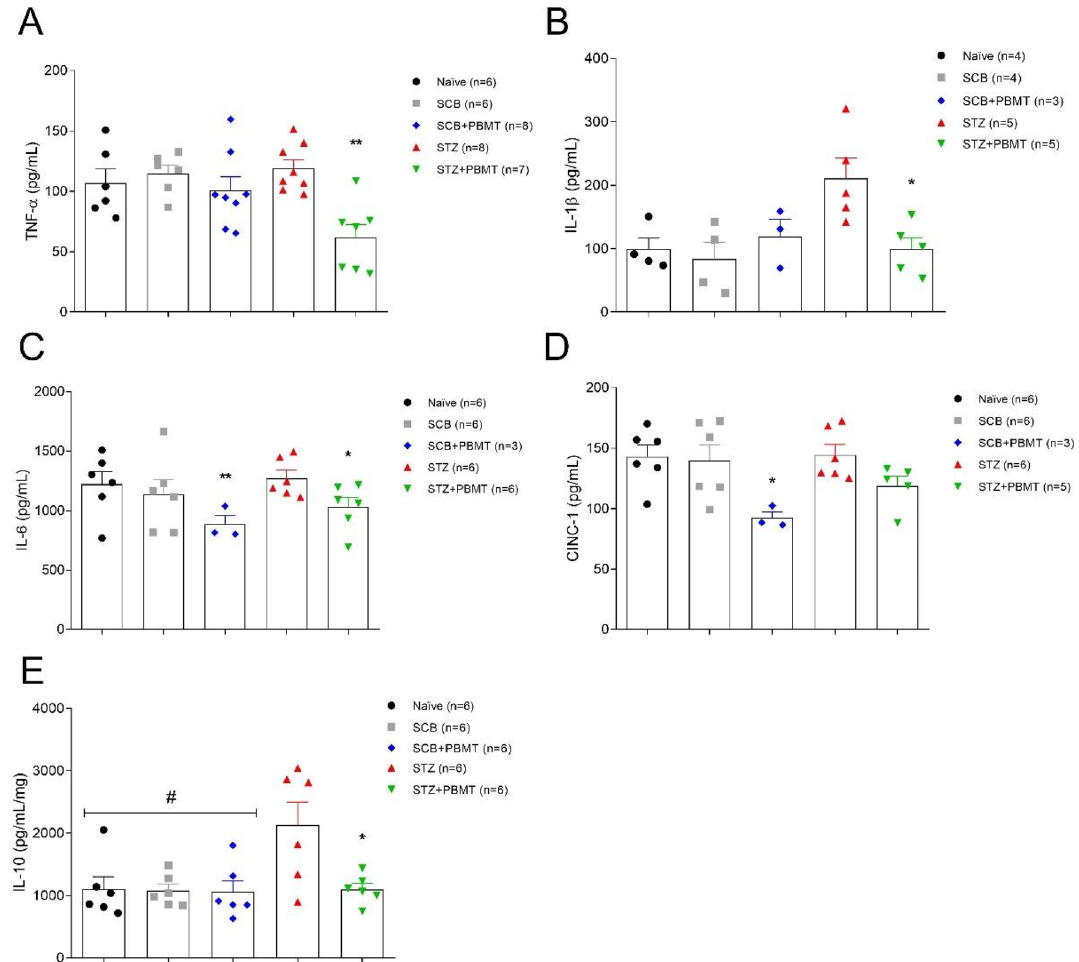
Figure 3. Effects of PBMT over the DRG levels of TNF-α, IL-1β, IL-6, CINC-1, and IL-10. ( A ) There was no increase in the levels of TNF-α (pg/mL) in the STZ group (red symbols); the STZ + PBMT group (green symbols) showed a significant reduction in the levels of TNF-α (pg/mL) in comparison to all the other groups. ( B ) For the levels of IL-1β (pg/mL), there was a significant increase in the STZ group (red symbols) in comparison with all the other groups. ( C ) Levels of IL-6 (pg/mL) were reduced significantly in SCB + PBMT (blue symbols) and STZ + PBMT (green symbols) groups, in comparison to all the other groups. ( D ) CINC-1 concentrations (pg/mL) showed a significant reduction in the SCB + PBMT group (blue symbols) only. ( E ) Levels of IL-10 (pg/mL/mg) showed a significant increase in the STZ group (red symbols) in comparison to all the other groups. Data are expressed as mean ± S.E.M.; symbols (*) and (**) mean p < 0.05 and p < 0.01, respectively; symbol (#) means that all control groups are significantly different from the STZ group (p < 0.05); One-way ANOVA followed by Bonferroni posthoc